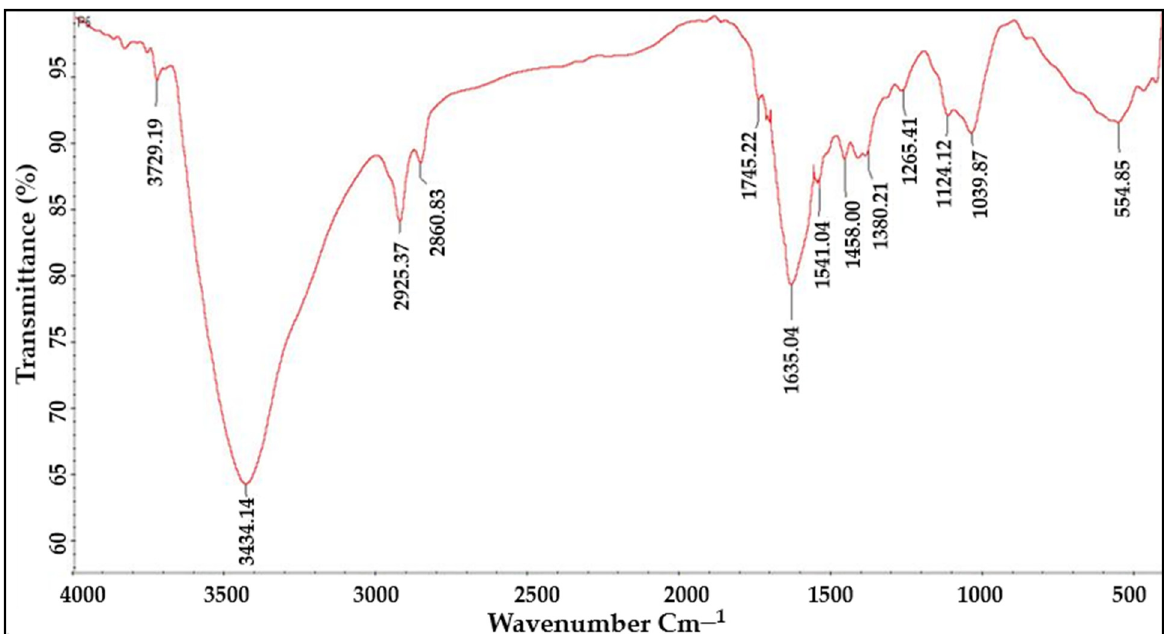
Figure 5. FTIR analysis of aqueous leaf extract of R. apiculata to determine its functional groups.